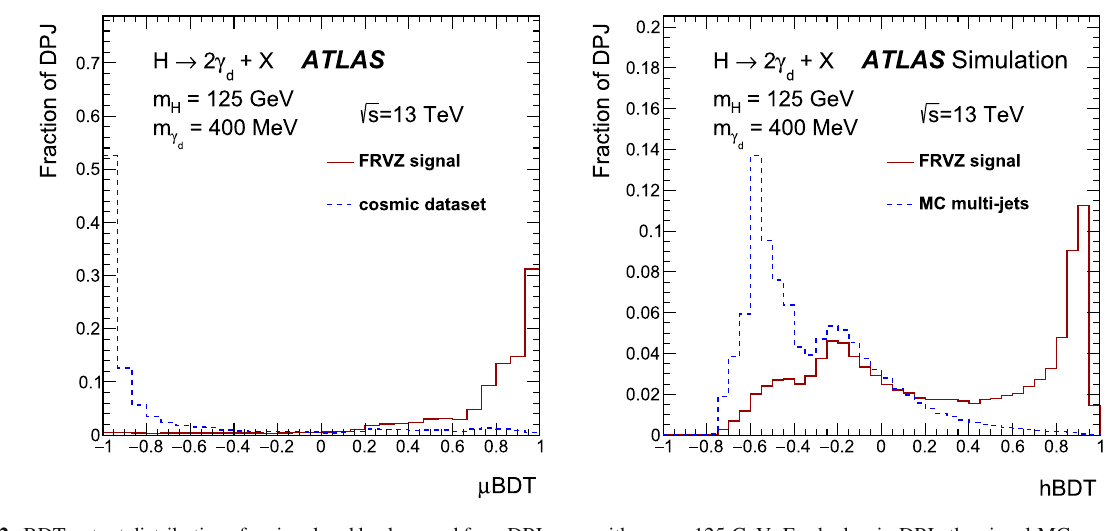
with m H = 125 GeV. For hadronic-DPJs the signal MC sample is the H → 2 γ d + X process with m H = 125 GeV and the background is the simulated multi-jet background